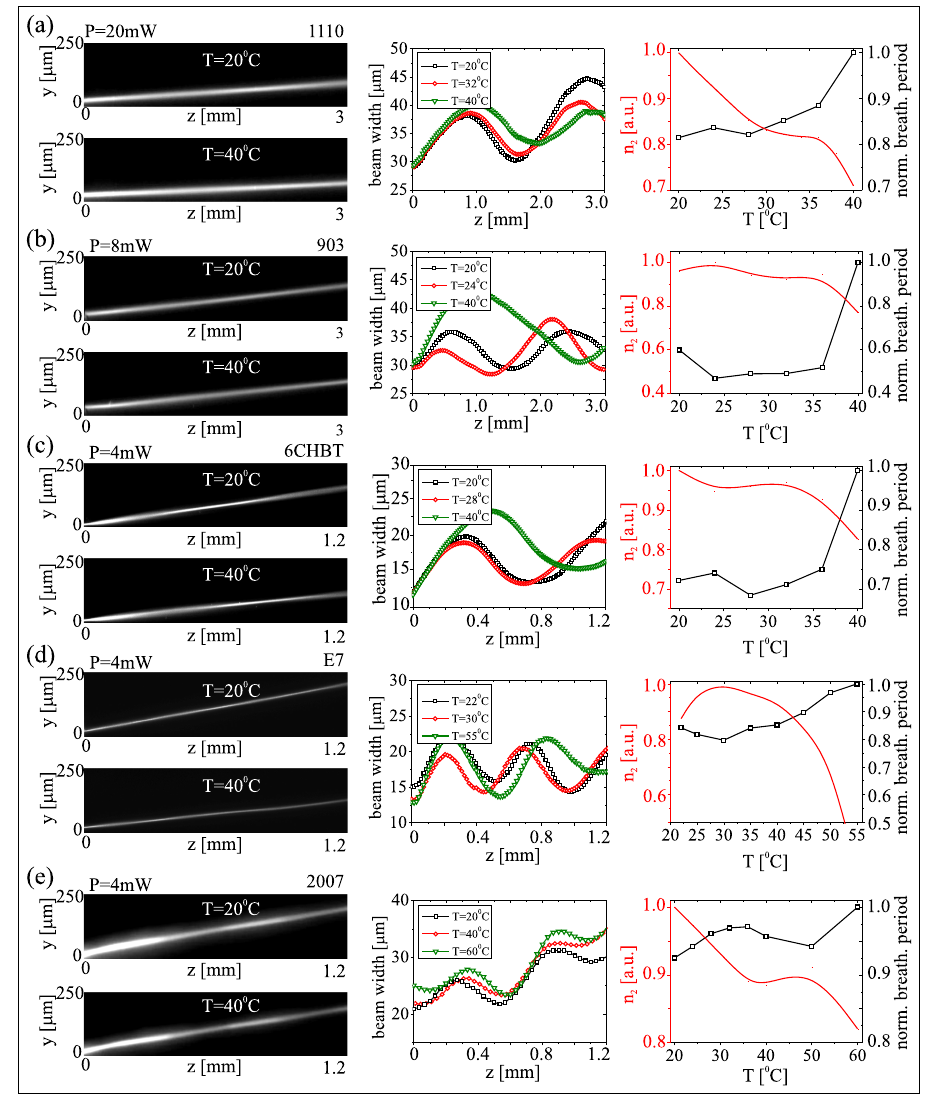
Figure 5. ( Left ): acquired images of beam evolution in the plane yz at two temperatures in each mixture from ( a – e ), respectively, as labeled. ( Center ): measured beam width versus propagation at various temperatures (see legends). ( Right ): calculated parameter n 2 and measured breathing period after scaling to the maximum